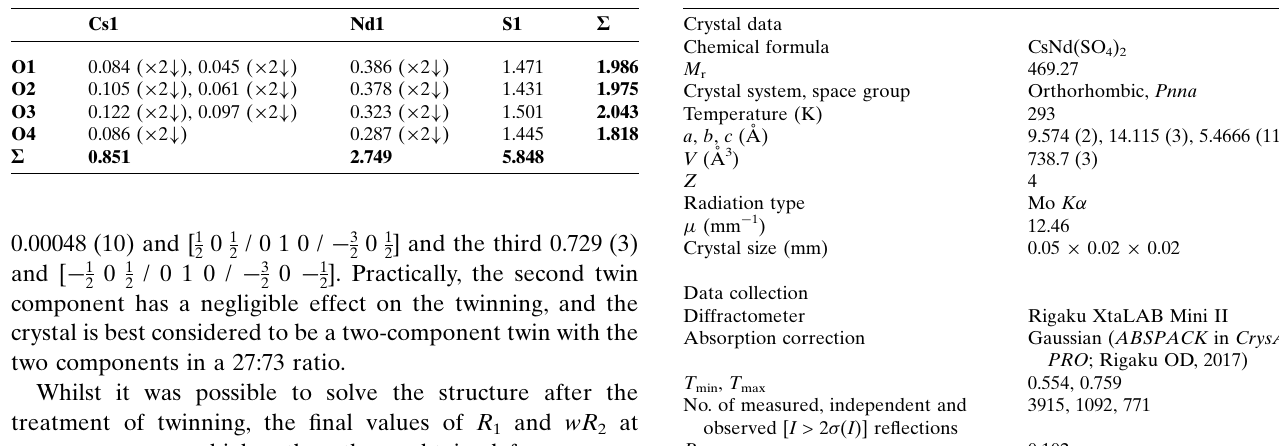
Table 2 Bond-valence sums (in valence units) for atoms in CsNd(SO 4 ) 2 .